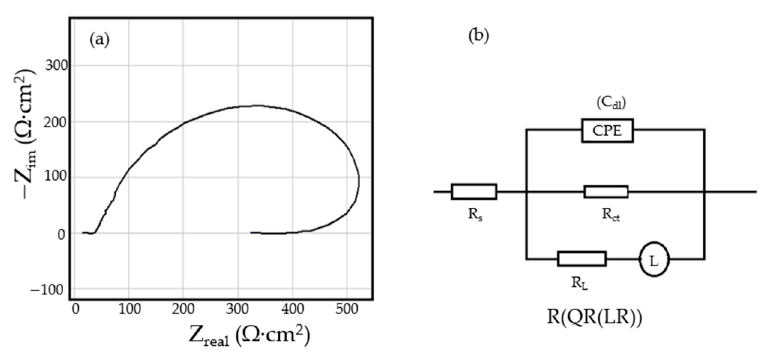
Figure 2. The Nyquist diagram ( a ) and equivalent circuit ( b ) for C45 sample, after one hour of immersion in BSW.